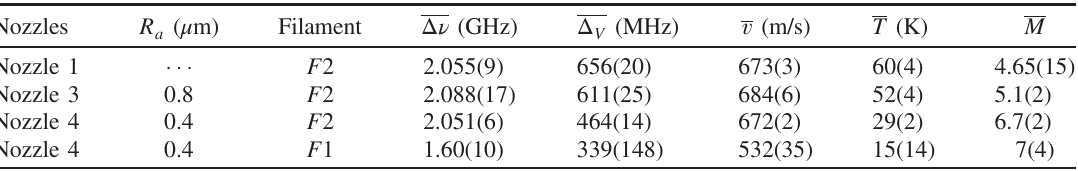
TABLE II. Characterization of the flow properties of jets formed by de Laval nozzles for few cases of the designed nozzle geometry, surface roughness of the inner contour R a , and the temperature inside the gas cell T 0 (or, equally, which of the filaments F 1 or F 2 was used to feed copper into the argon flow). The values of the Doppler shift Δ ν , ¯ T spectral linewidth Δ V , velocity v , temperature , and Mach number M are presented. The surface roughness of the inner contour of nozzle 1 was not measured within these